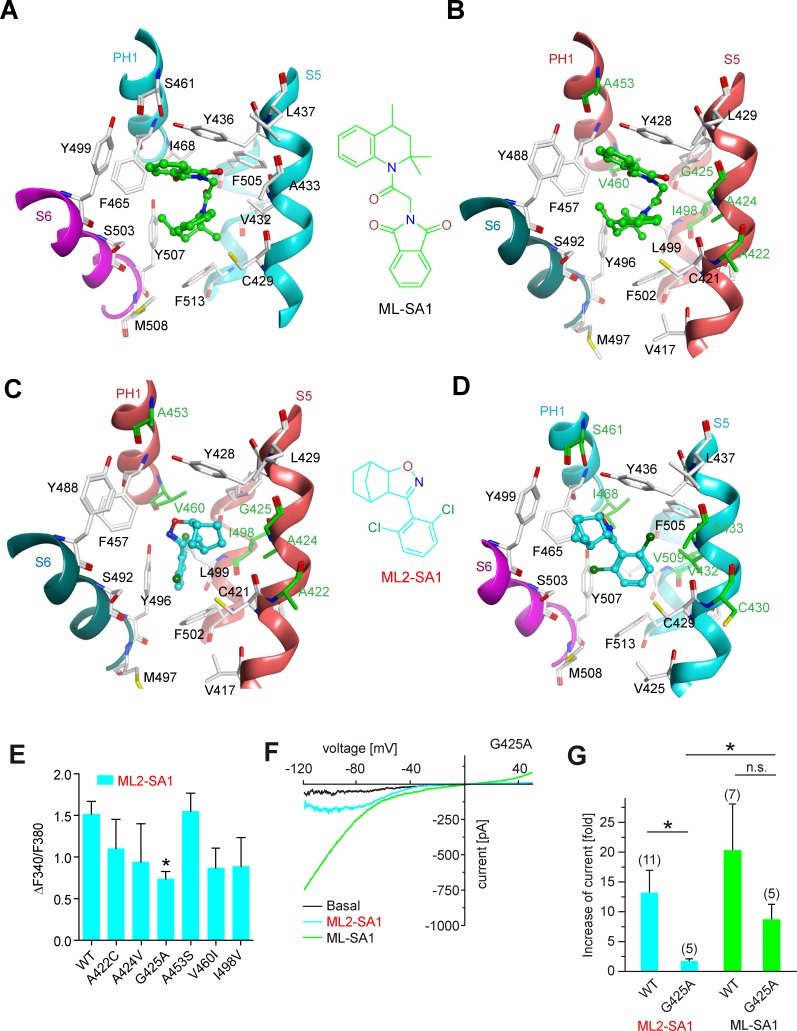
Molecular modeling of ML2-SA1 and ML-SA1 binding.(A) Binding mode of ML-SA1 (green colored carbon atoms) at hTRPML1, showing residues within 5 Å of ML-SA1, as observed in one of the four identical binding pockets of the cryo-EM structure (PDB ID: 5WJ9). The S6 helix of monomer A of hTRPML1 is colored magenta, the PH1 and S5 helices of monomer B are colored cyan. (B) Binding mode of ML-SA1 (green colored carbon atoms) at hTRPML2 (homology model generated with MODELLER) as predicted by the ligand docking. Only residues within 5 Å of ML-SA1 in one of the four identical binding pockets are displayed. The S6 helix of monomer A of hTRPML2 is colored petrol blue, the PH1 and S5 helices of monomer B are colored salmon. Amino acid residues that are different in hTRPML1 and hTRPML2 are colored green (C) Binding mode of one ML2-SA1 enantiomer (cyan colored carbon atoms; 3aS, 4S, 7R, 7aS) at hTRPML2 as predicted by ligand docking. Only residues within 5 Å of ML2-SA1 in one of the four identical binding pockets are displayed (same coloring and representation style as in Figure 3B). Binding of the other ML2-SA1 enantiomer (3aR, 4R, 7S, 7aR) resulted in a similar binding mode that is shown in Figure 3—figure supplement 1B (D) Binding mode of one ML2-SA1 enantiomer (cyan colored carbon atoms; 3aS, 4S, 7R, 7aS) at hTRPML1 as predicted by ligand docking. Only residues within 5 Å of ML2-SA1 in one of the four identical binding pockets are displayed (same coloring and representation style as in Figure 3a). (E) Fura-2 calcium imaging results showing the effect of ML2-SA1 (10 μM) on hTRPML2-YFP WT and mutant transfected HEK293 cells. Mean values normalized to basal (120 s after compound application)±SEM of at least three independent experiments, each. * indicates p<0.05, one-way ANOVA, followed by Dunnet post-hoc test. (F) Representative ML2-SA1 or ML-SA1 (10 μM) elicited currents from YM201636-enlarged LE/LY isolated from hTRPML2(G425A) expressing HEK293 cells. (G) Statistical summary of data as shown in F as fold increase compared to the respective basal currents in LE/LY. Shown are mean values ± SEM at −100 mV of at n independent experiments as indicated. * indicates p<0.05, unpaired t-test.